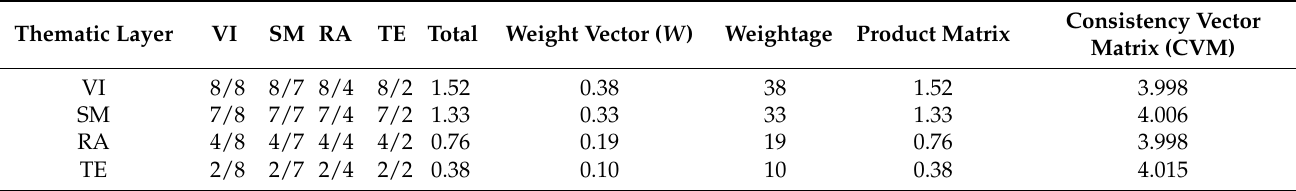
Table 2. Normalized pairwise comparison matrix and the final